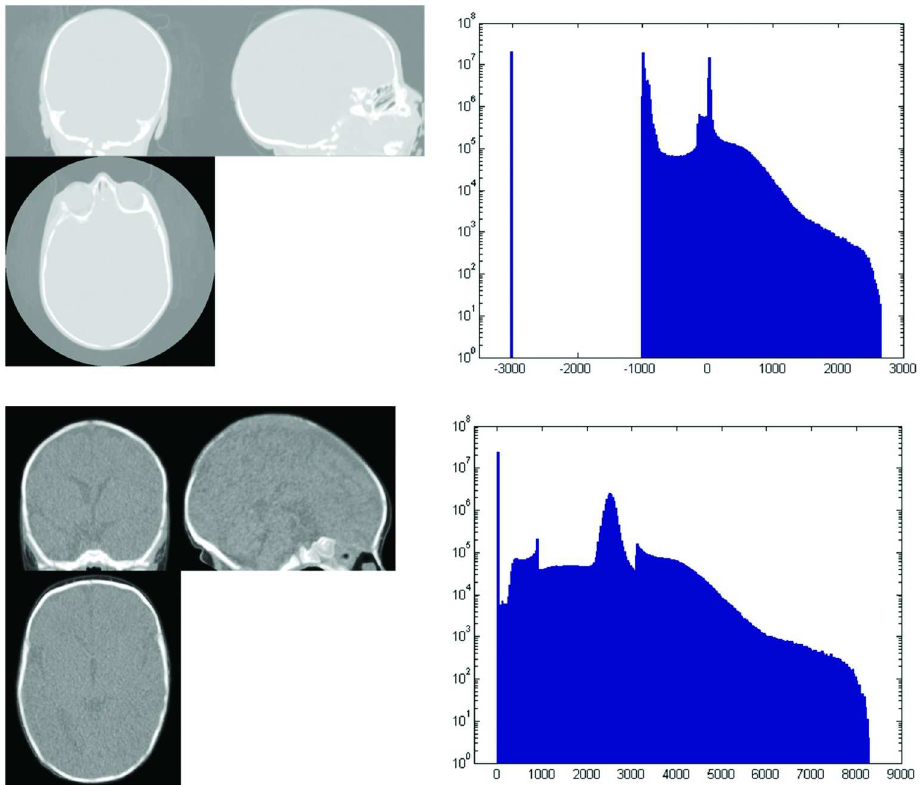
Fig 2. Original and preprocessed CT images and related histogram